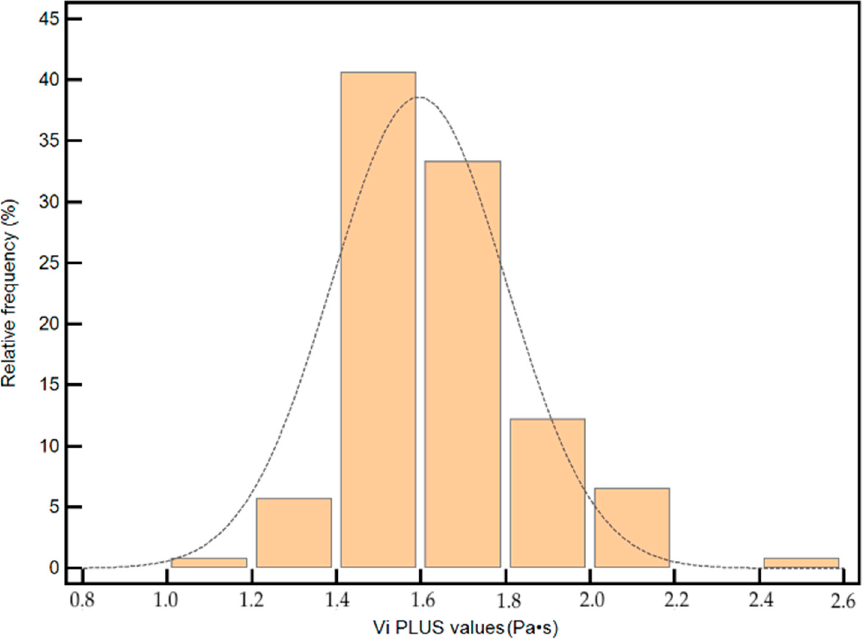
Figure 3. The distribution of Vi PLUS values in normal subjects. Approximately 88% of Vi PLUS values were in the range